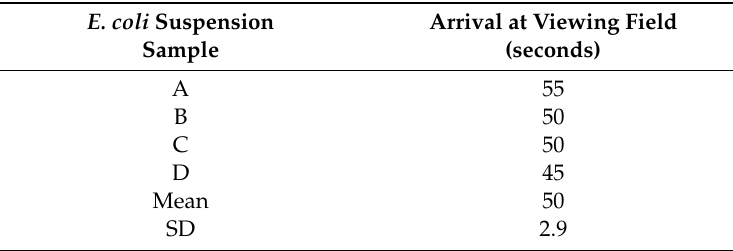
Table 1. Timing of cell suspension arrival in the central part of Ibidi flow cell channel (in seconds from the start of